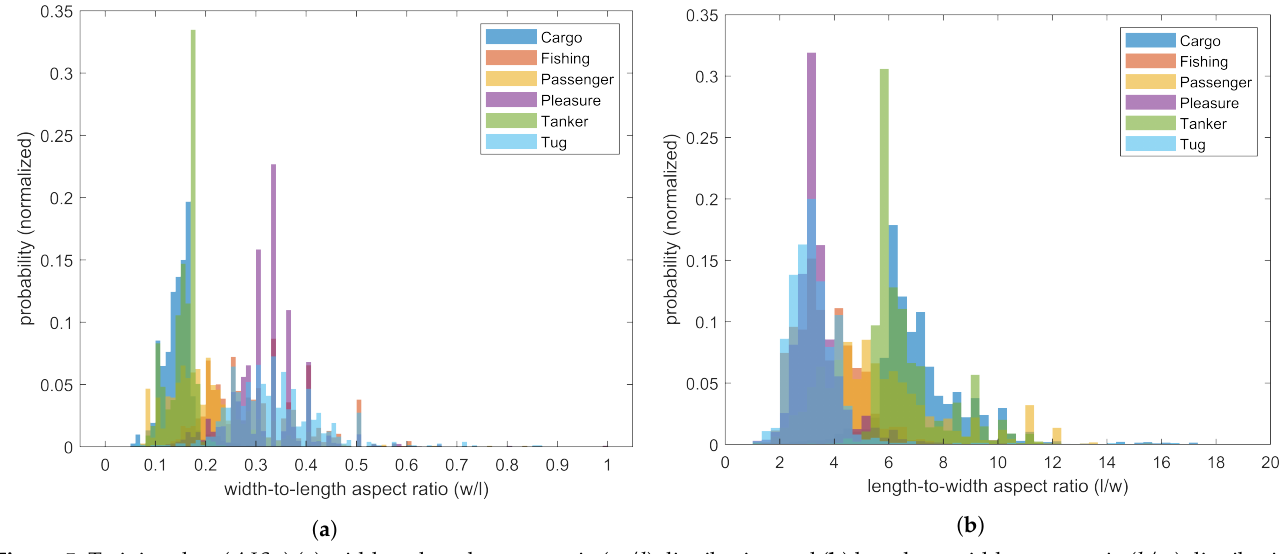
Figure 5. Training data ( AIS C ) ( a ) width-to-length aspect ratio ( w / l ) distribution and ( b ) length-to-width aspect ratio ( l / w ) distribution for each ship type. Table 3. Trained model results and MATLAB ® model